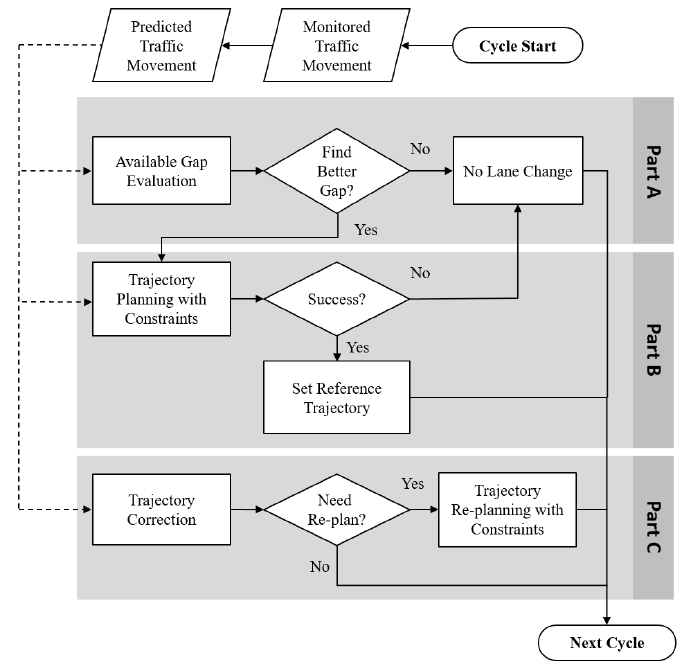
Figure 1. The control diagram of the lane change algorithm with three parts: identification of available vehicle gaps, trajectory planning and trajectory